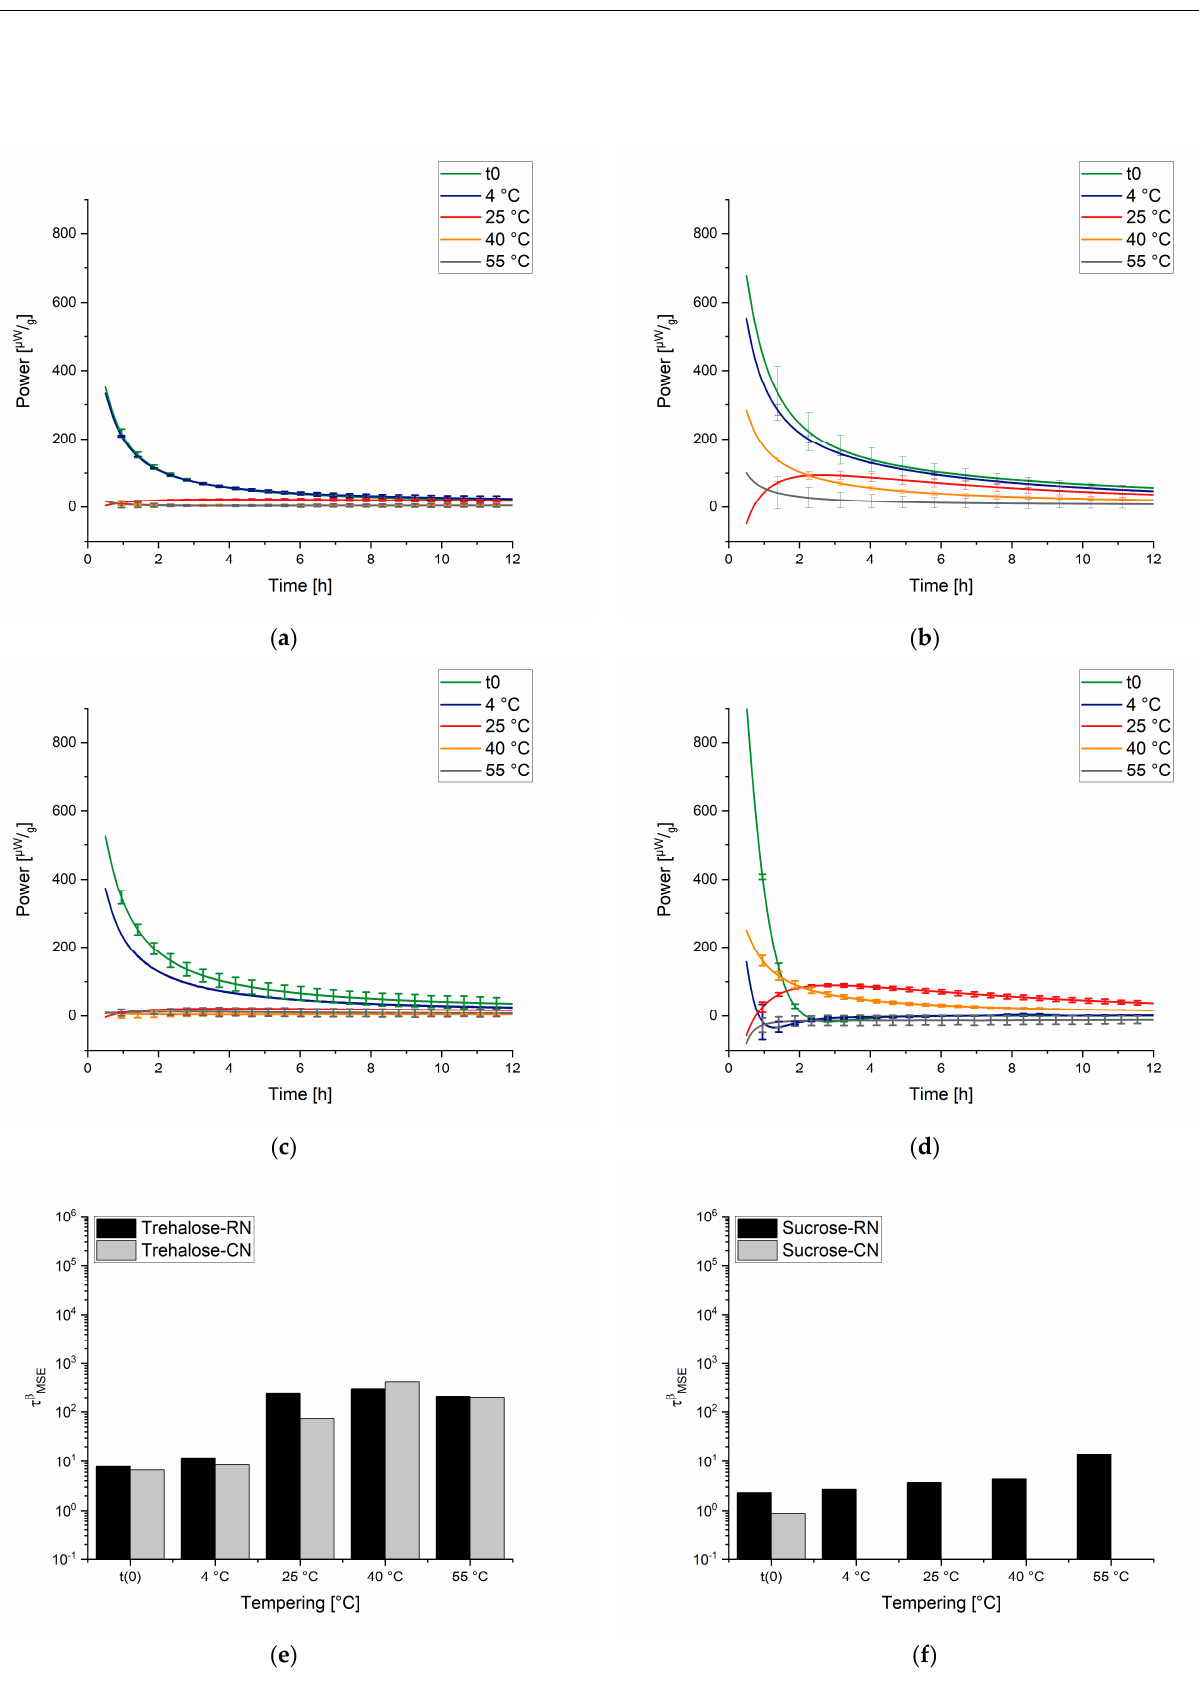
Figure 8. Isothermal measurements performed at 40 °C. Freshly prepared sample (green), 4 °C tempered sample (blue), 25 °C tempered sample (red), 40 °C tempered sample (orange), 55 °C tempered sample (grey). ( a ) Trehalose-RN, ( b ) Sucrose-RN, ( c ) Trehalose-CN, ( d ) Sucrose-CN, ( e , f ) calculated values of τ β [ h ] . Missing bars indicate unsuccessful curve fitting.